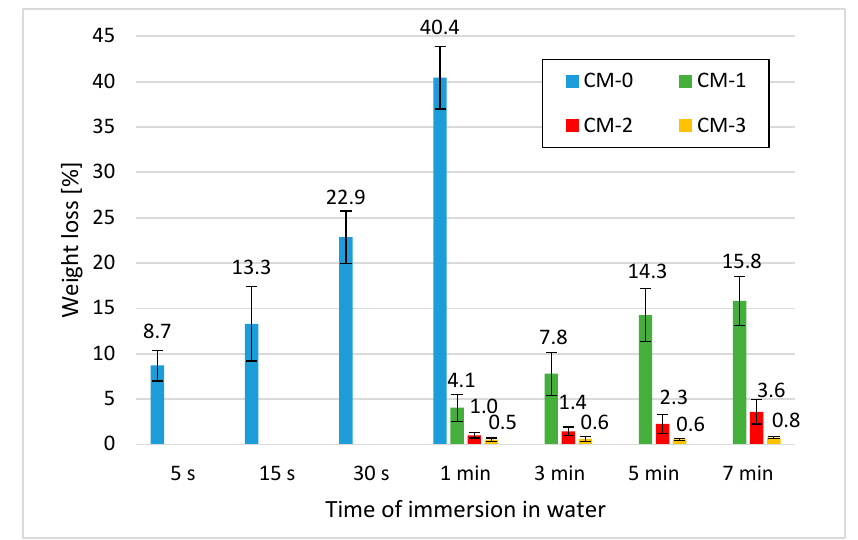
Figure 3. Weight loss of mortar samples after water immersion for a specified time.